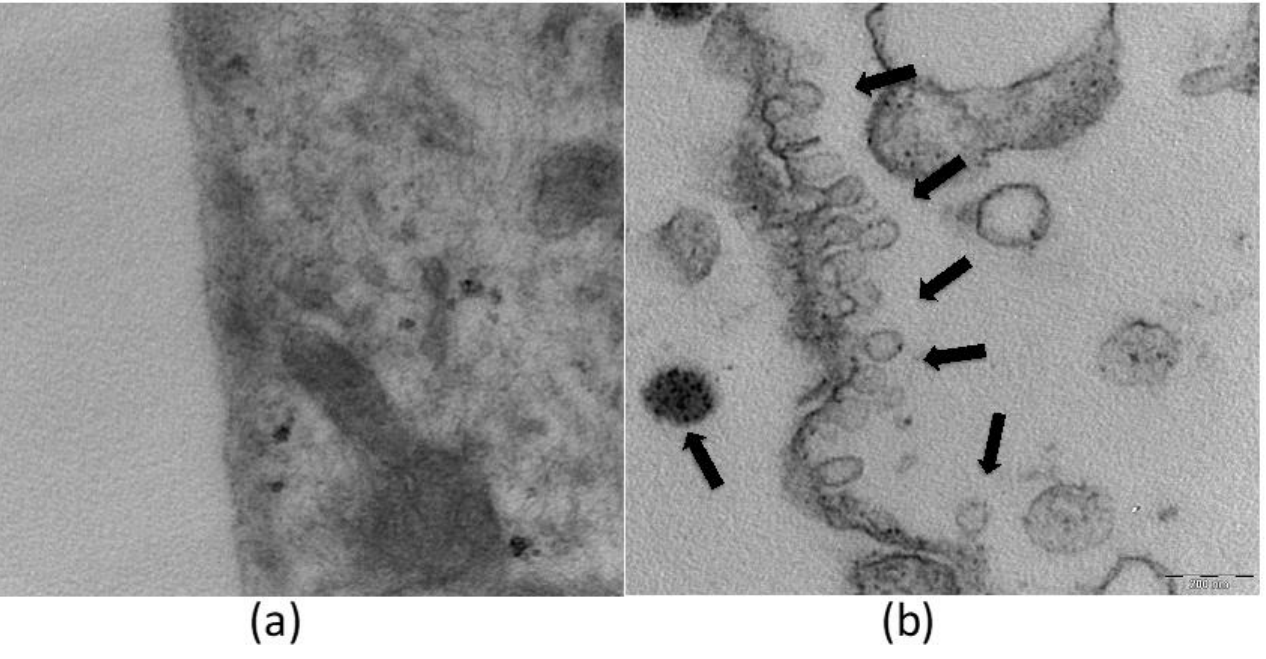
Figure 4. TEM images of fibroblasts untreated ( a ) and treated with ethosomes ( b ). Ethosomes (arrows) are clearly recognizable both outside and inside the cytoplasm. Bar corresponds to 200